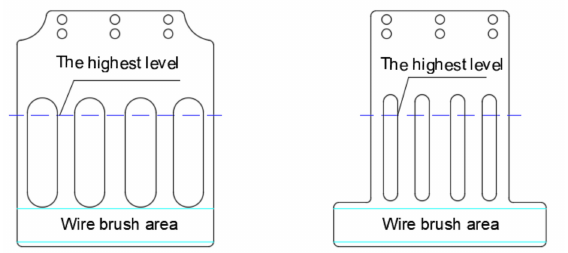
Figure 21. Comparison of D-brush and C-brush